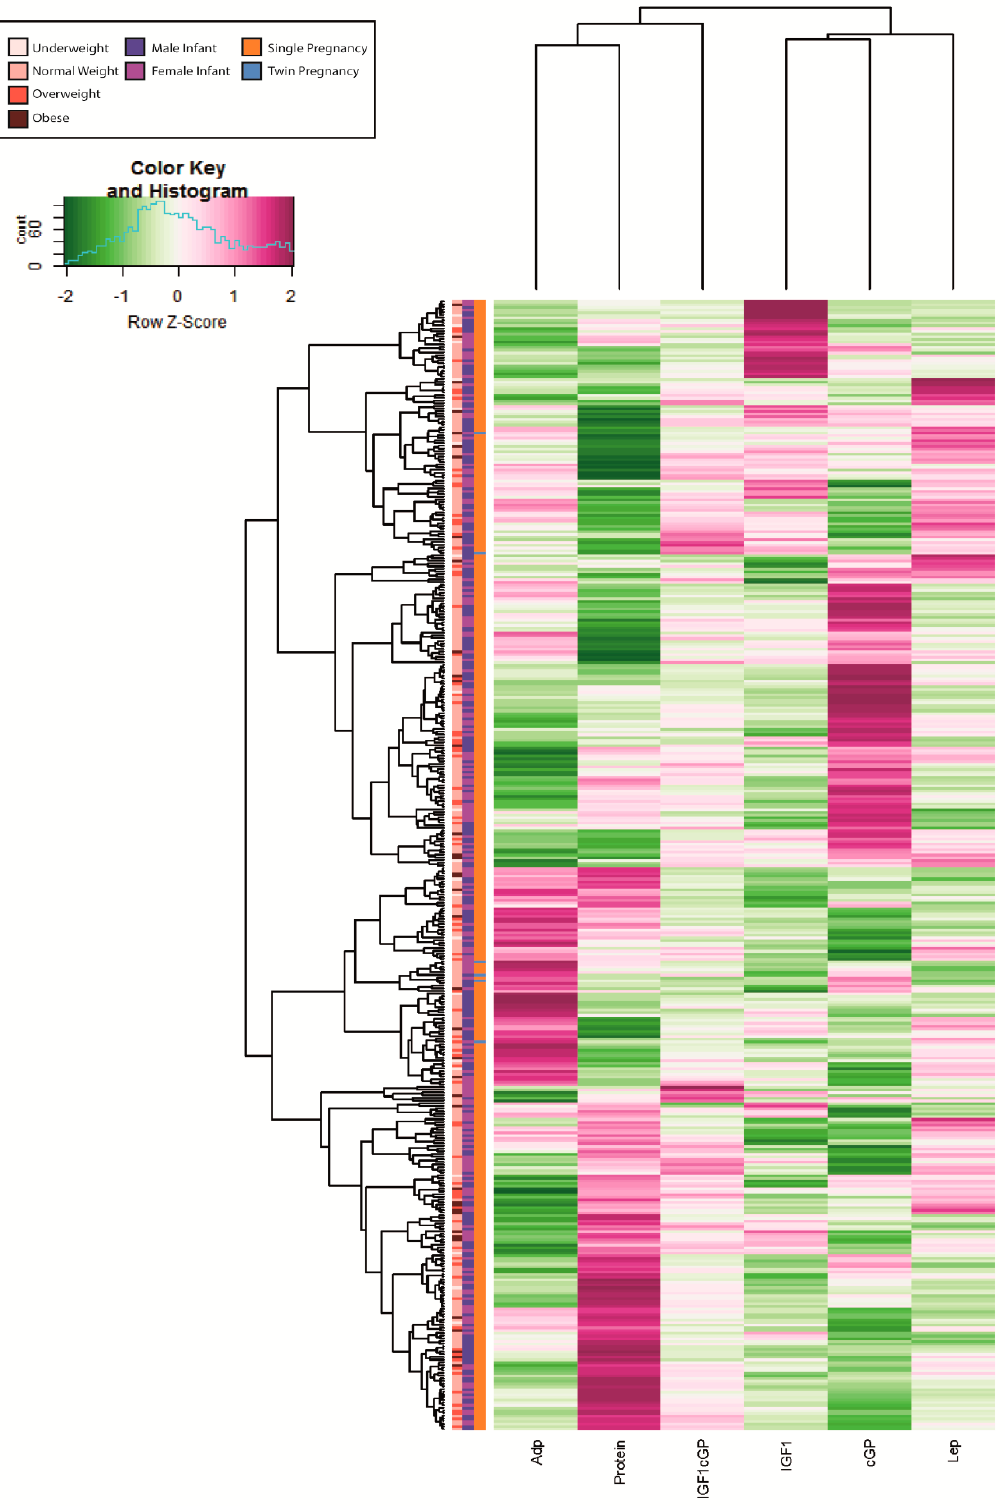
Figure 1. Heatmap displaying hormonal composition (z-scores) for 423 samples in the Finnish STEPS cohort. Only samples with no missing information were included in the heatmap. Adp = Adiponectin, IGF1 = Insulin-like growth factor 1, cGP = cyclic-Glycine-Proline, IGF1cGP = IGF1/cGP ratio, Lep = leptin. The missing samples have been excluded due to missing information for one or more hormone measurements.